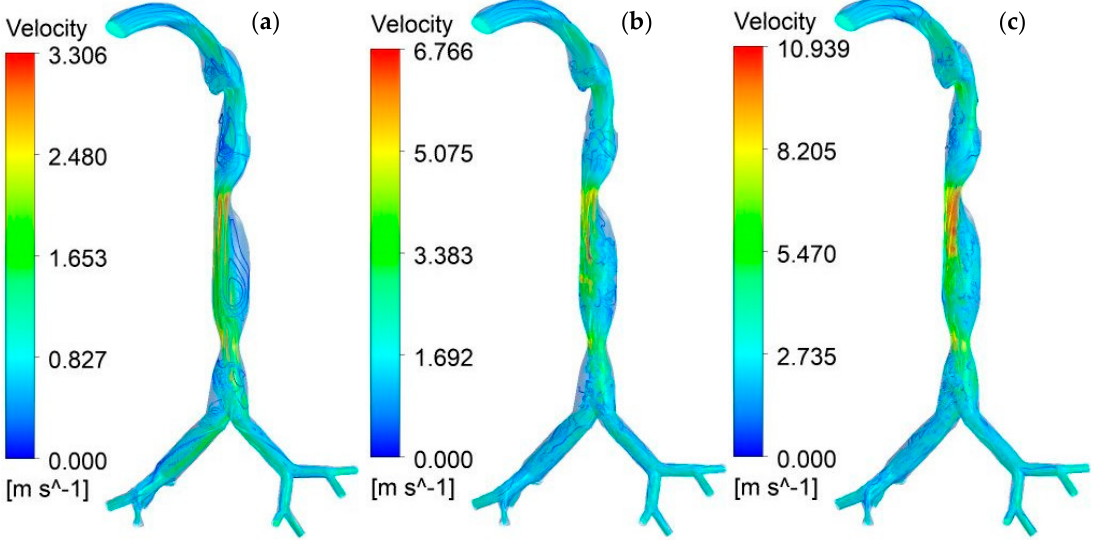
Figure 10. Airflow streamlines during inhalation conditions with three different airflow rates: ( a ) 7.5 L/min; ( b ) 15 L/min; and ( c ) 25 L/min.